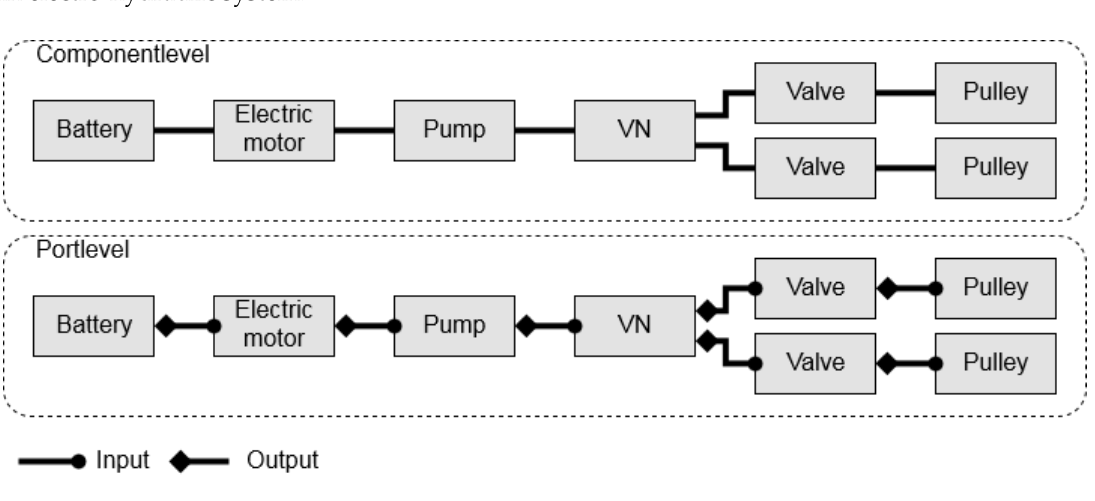
Figure 8. Example topology with two different levels of